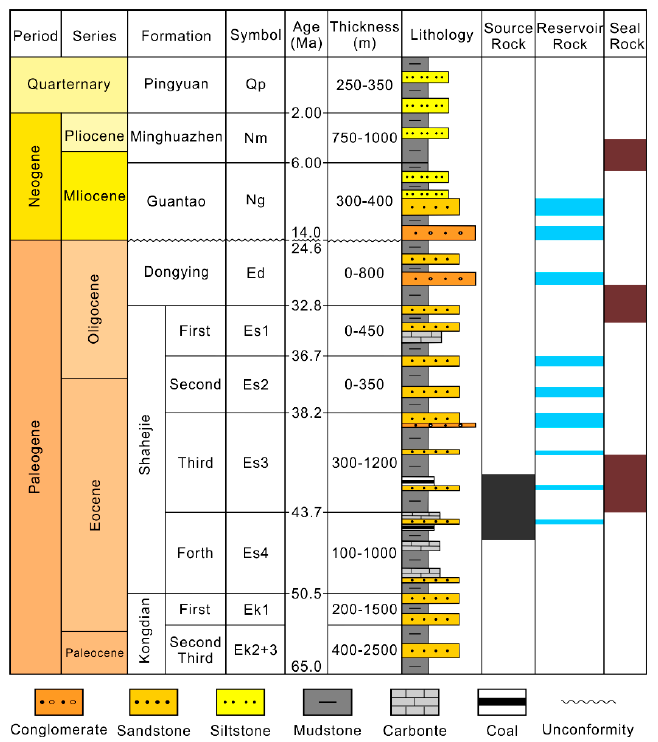
Figure 2. General Cenozoic stratigraphy of the Linnan Sag. The age, thickness, and lithology of each formation and the potential source, reservoir, and caprocks are shown.